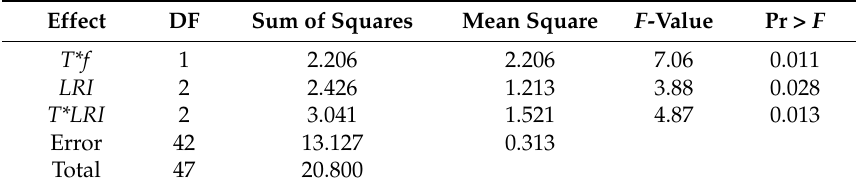
Table 8. Outcome of the last iteration for the ANOVA over Ra Naperian